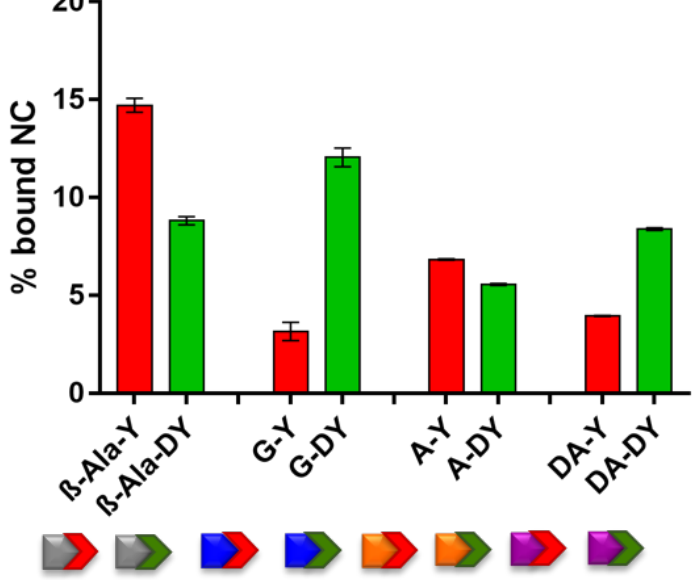
Figure 4. Histograms comparing the fractional occupancy of L -Tyr (red) and D -Tyr (green) series of compounds (see pictograms for side chain amino acid identities). Data were obtained from analyses of the ESI-MS spectra of reaction mixtures containing the full length NC protein and each compound (molar ratio compound: NC = 10:1) in 150 mM ammonium acetate.